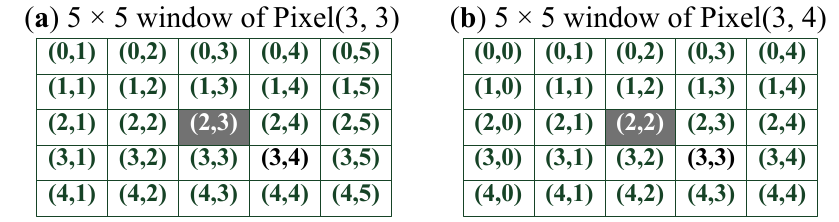
Figure 3. The Data Difference between two 5 × 5 windows of the adjacent pixels. ( a ) 5 × 5 window of Pixel(3, 3) ( b ) 5 × 5 window of Pixel(3,